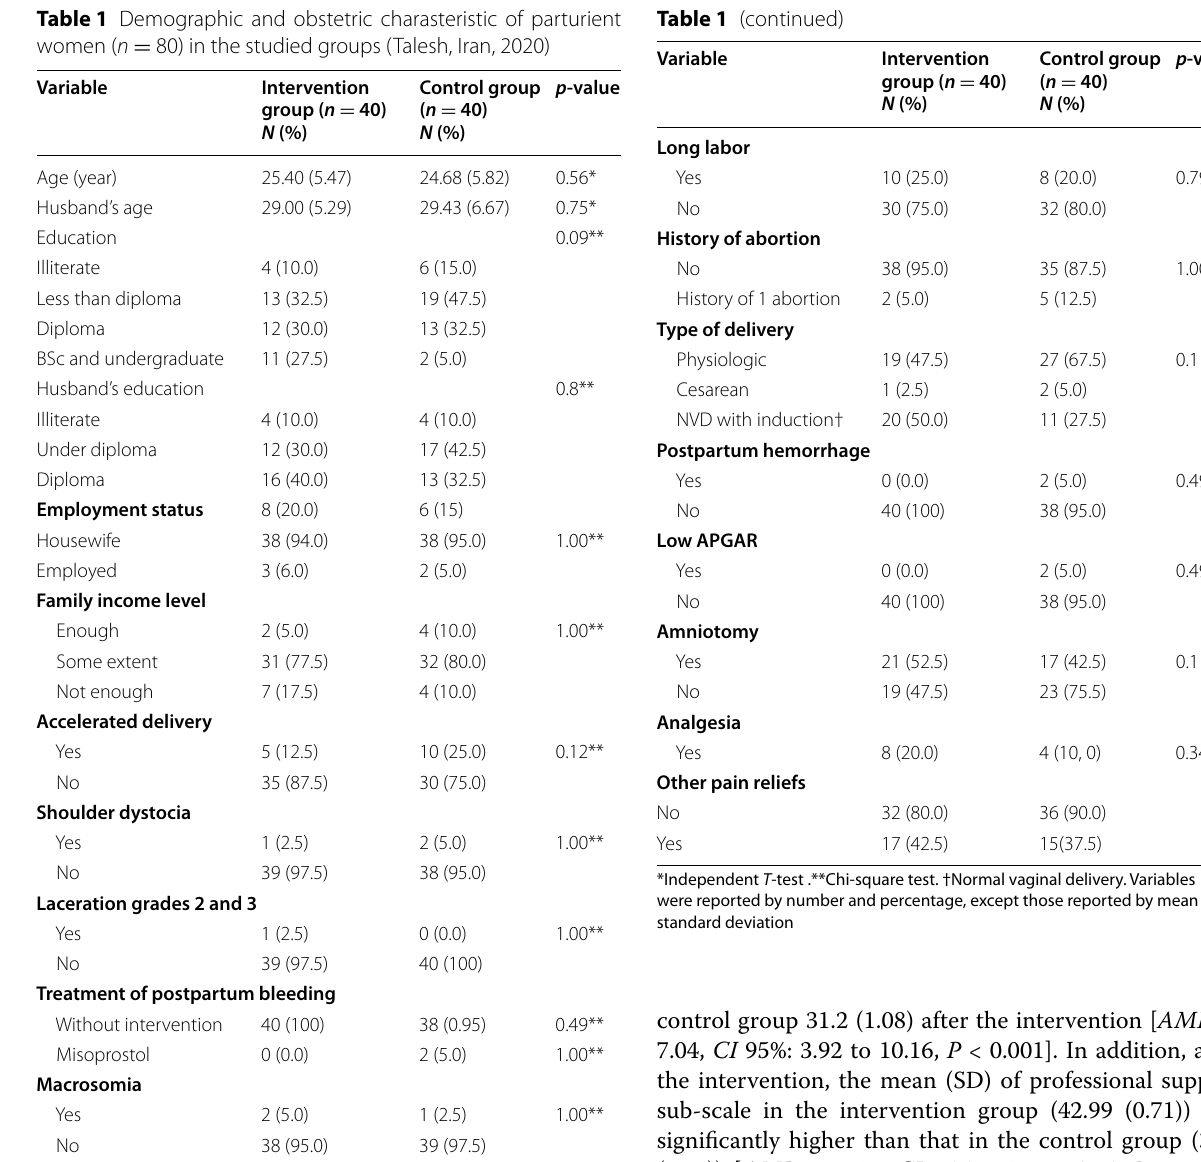
3.3 The childbirth experiences After controlling the effect of support and control in childbirth, the mean (SD) of the scores of childbirth experience in the intervention group was significantly higher than that in the control group (51.23 (1.54) versus 45.33 (1.54), [adjusted mean difference (AMD) 5.90, CI = 95%: 1.17 to 10.62, P 0.01]. =